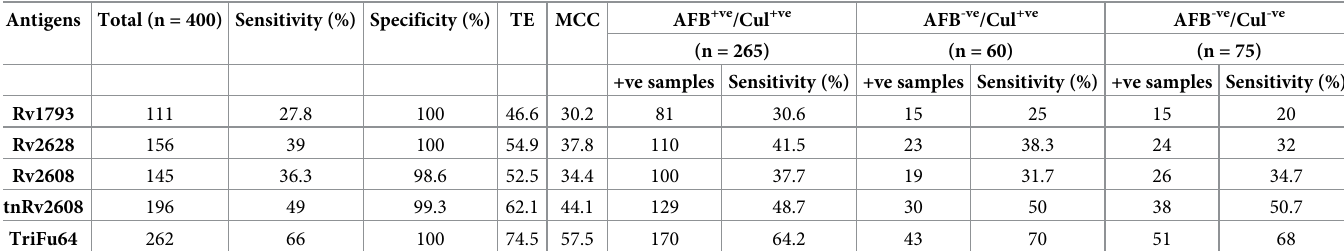
Table 4. Sensitivity and specificity of Mtb antigens against the total plasma samples and the sample groups based on smear and culture results. Antigens Total (n = 400) Sensitivity (%) Specificity (%) TE MCC